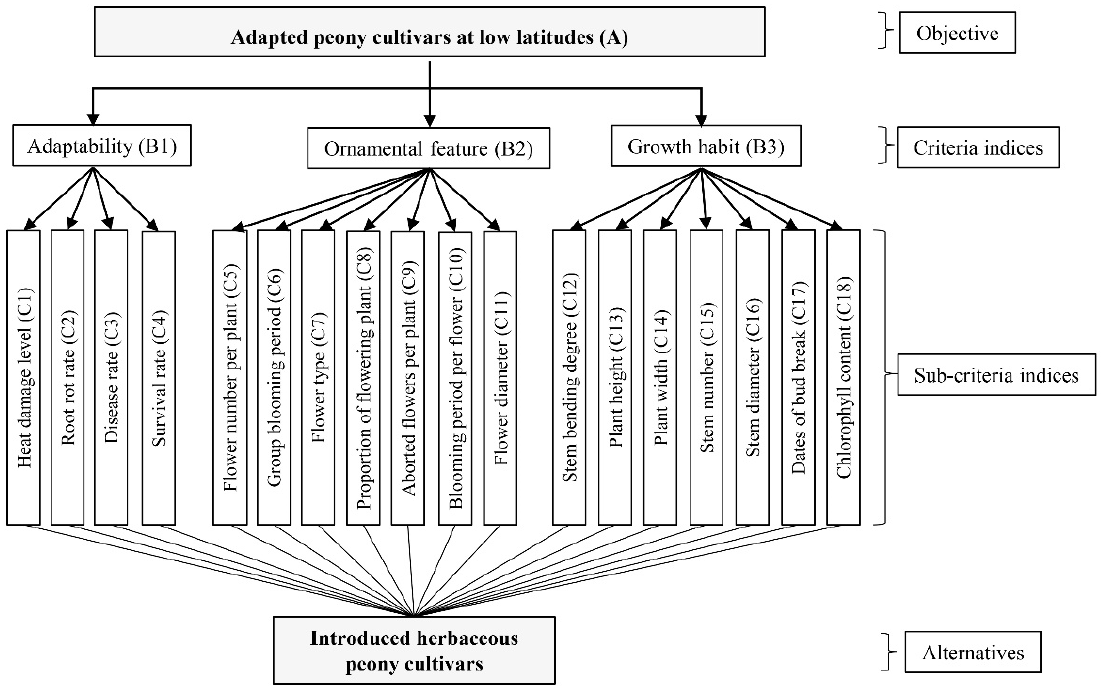
Figure 7. Decision hierarchy system of the MCDM model for evaluating the application potential of herbaceous peony cultivars at low latitudes.